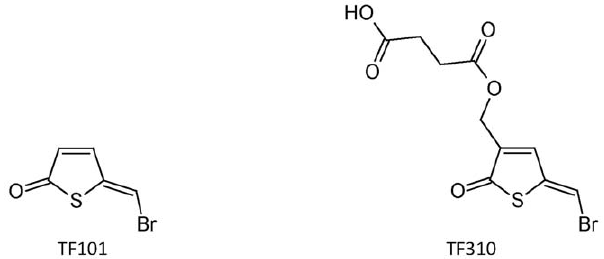
Figure 1. Structure of the brominated thiophenones used in this